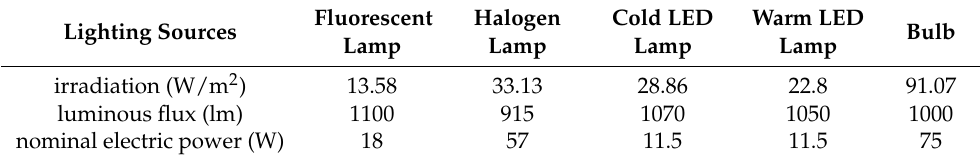
Table 3. The measured irradiation of the considered light sources.